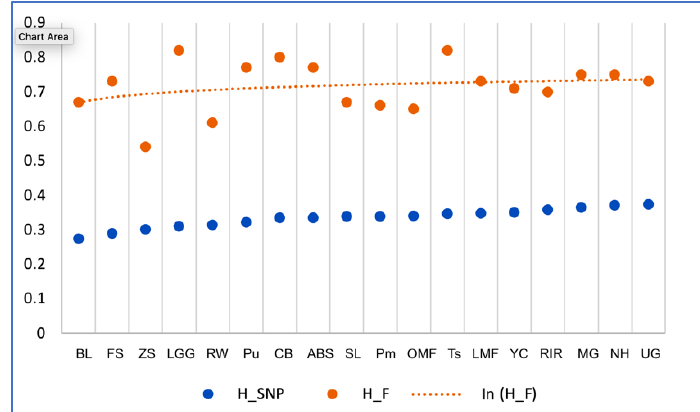
Figure 7. Heterozygosity of 18 populations assessed by various methods: H_SNP, H O values with SNP genotyping; H_F, 𝐻 ̅ 𝑂 values with multilocus DNA fingerprinting; ln (H_F), logarithmic trend SNP genotyping; H_F, H O values with multilocus DNA fingerprinting; ln (H_F), logarithmic trend 𝑦 (𝑥) = 𝑎 × ln (𝑥) + 𝑏 for the 𝐻 ̅ 𝑂 curve. y ( x ) = a × ln ( x ) + b for the H O